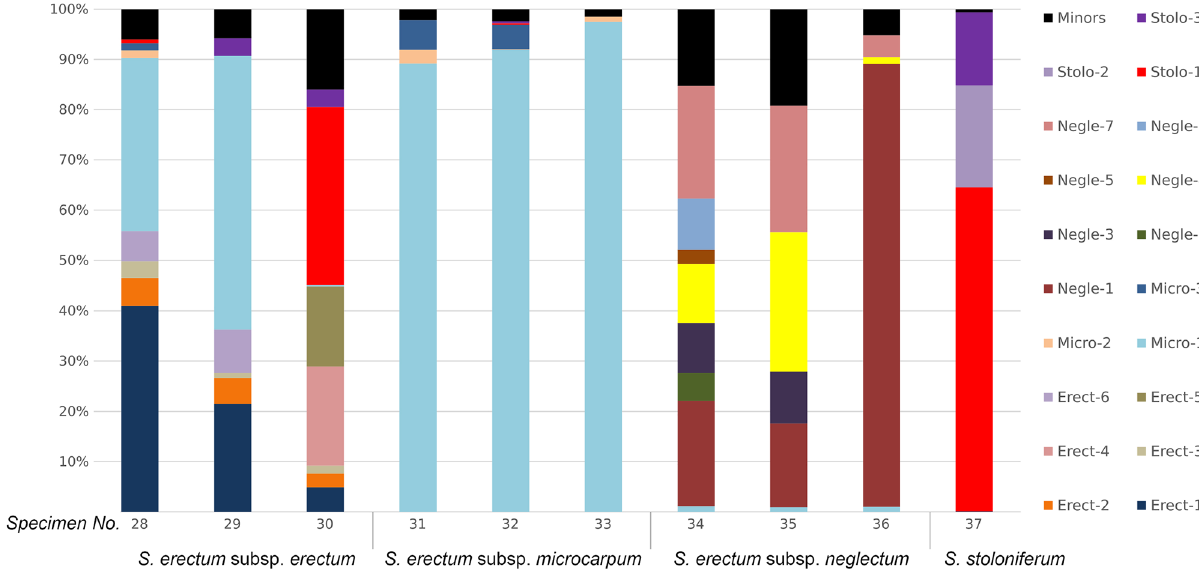
Figure 4. Stacked bar plots showing the relative abundance of the major ribotypes across the species of subgenus Sparganium section Erecta . Minor ribotypes in a sample are collectively termed Discussion Organization and evolution of 35S rDNA in plants.